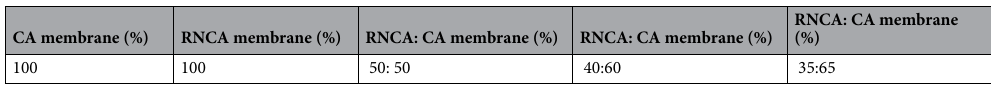
Table 1. The percentage mixture of RNCA and CA for studied membranes.